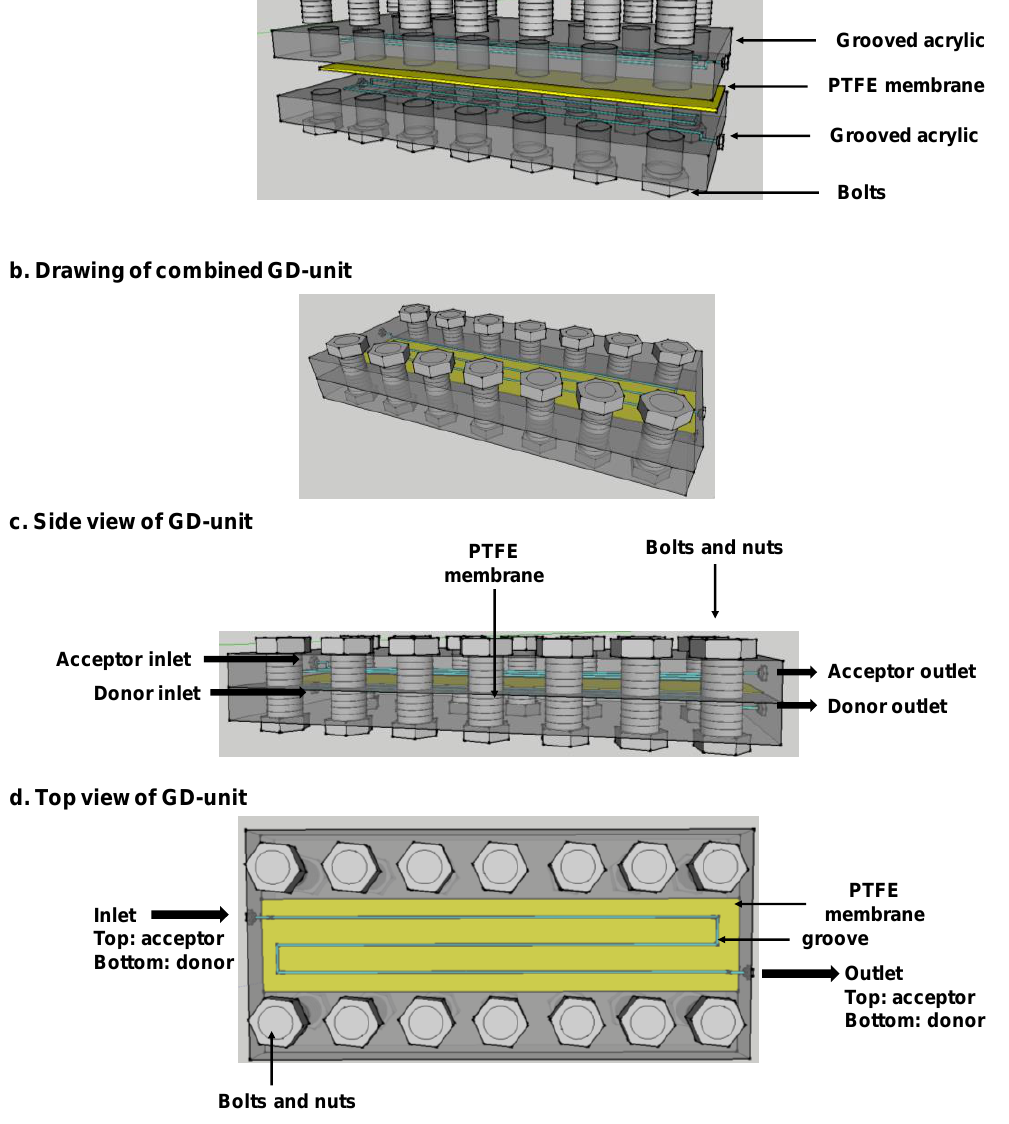
Figure A1. Drawing of gas-diffusion unit used in this work.